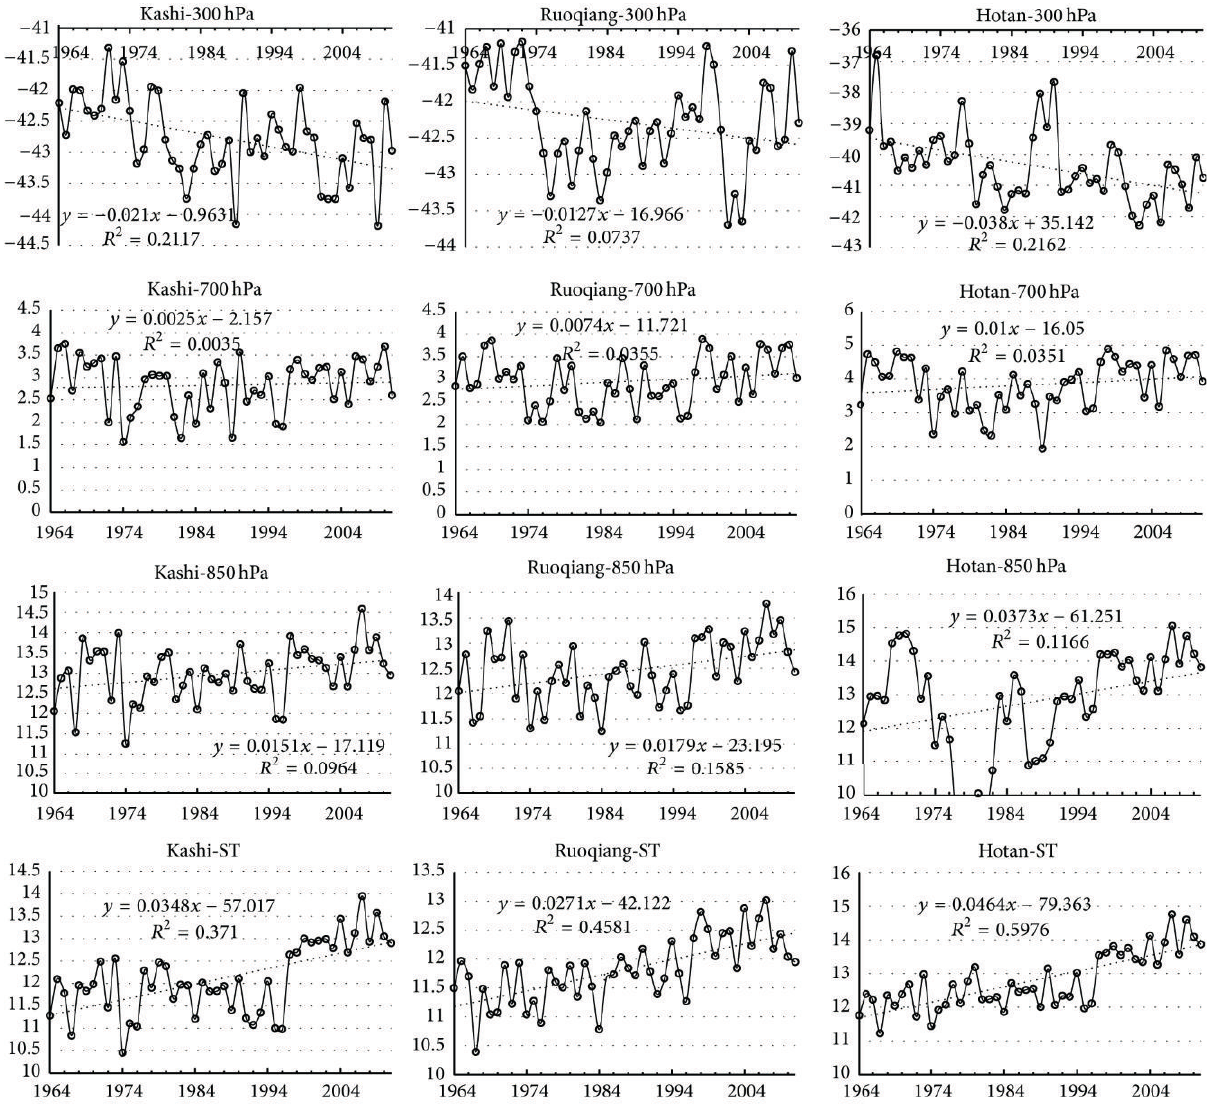
Figure 2: The temperature change of three